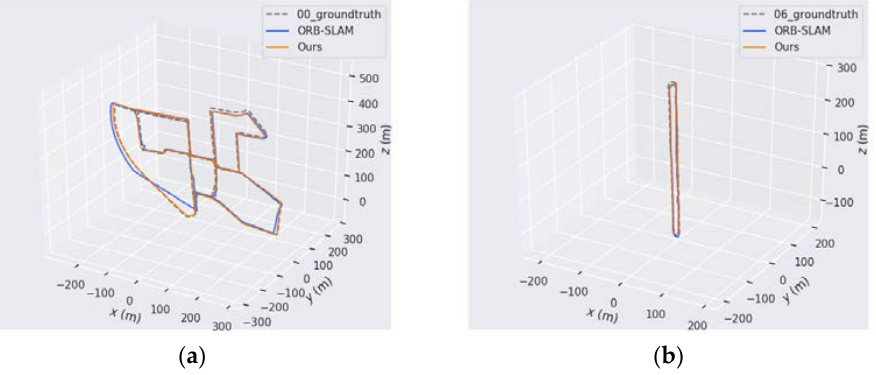
Figure 12. Performance of different algorithms on the different sequences of the KITTI dataset. ( a ) is the 00 sequence with multiple loops, ( b ) is the 06 sequence with long road and one loop.